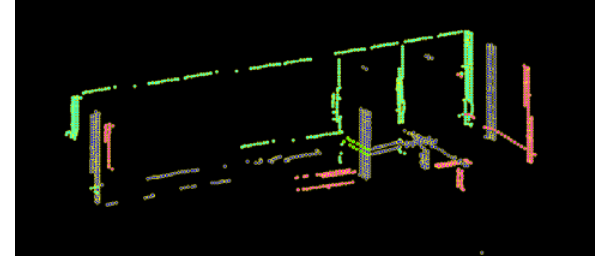
Figure 8. Intersection lines resulting from plane intersection. Figure 6. Point cloud with points classified according to the direction of their normal vector: parallel to the main wall in grey, perpendicular to the main wall in magenta and horizontal surfaces in cyan.